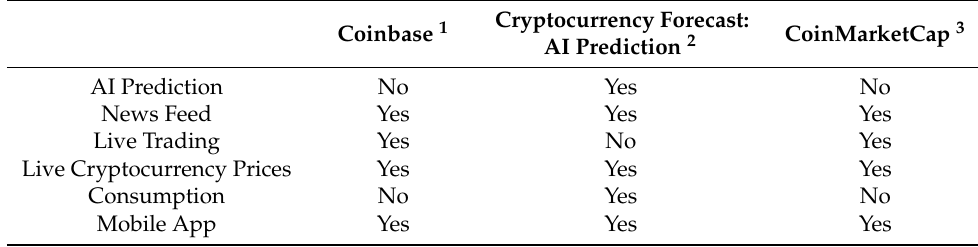
Table 1. A comparison of features across chosen